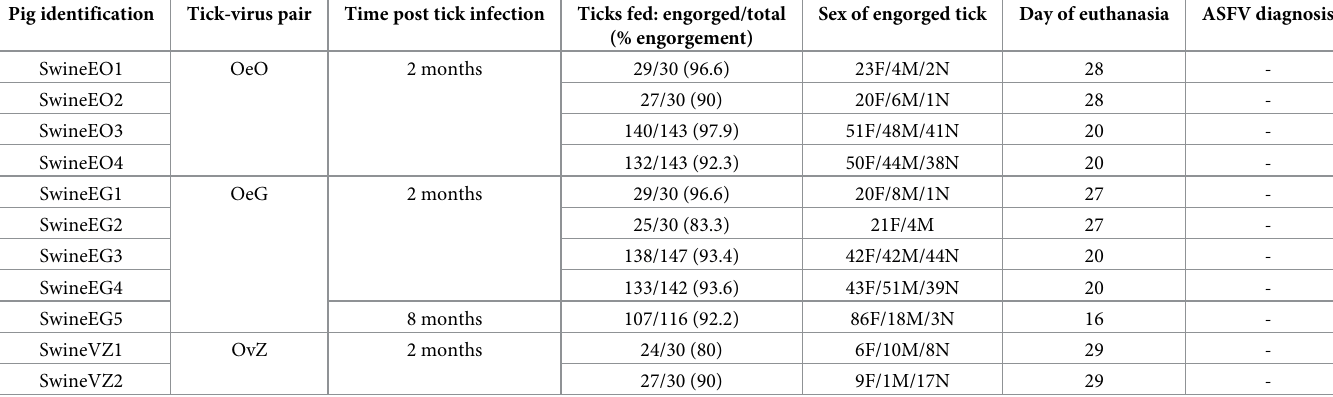
Table 3. Lack of ASFV transmission by O . erraticus and O . verrucosus ticks. Experiments involved ticks previously exposed to ASFV strains. F = female, M = male, N = Nymph, OeO = O . erraticus -OurT88/1, OeG = O . erraticus -Georgia2007/1, OvZ = O . verrucosus -Zapo. Pig